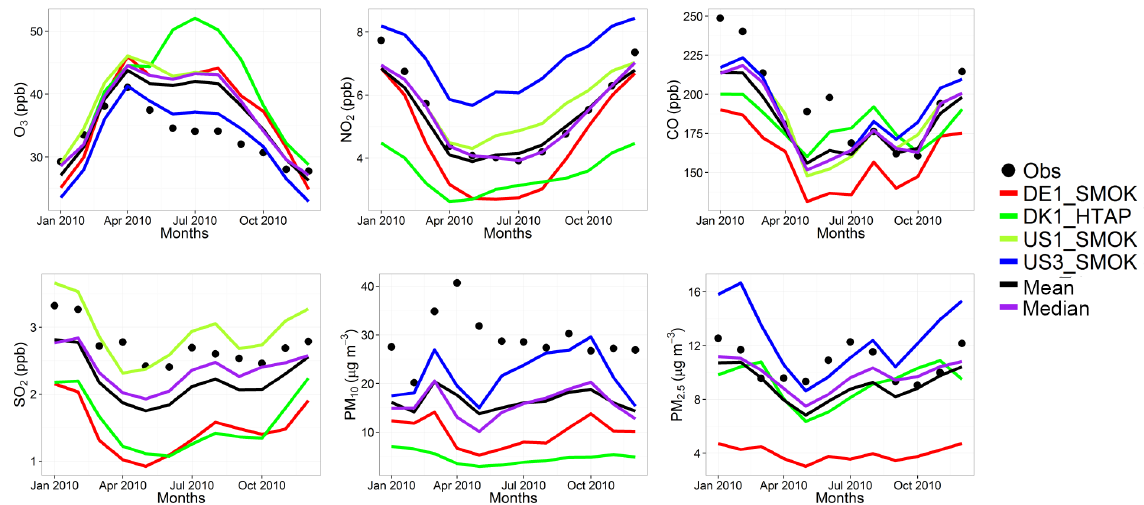
Figure 2. Observed and simulated monthly mean air pollutant levels, averaged over the monitoring stations over North